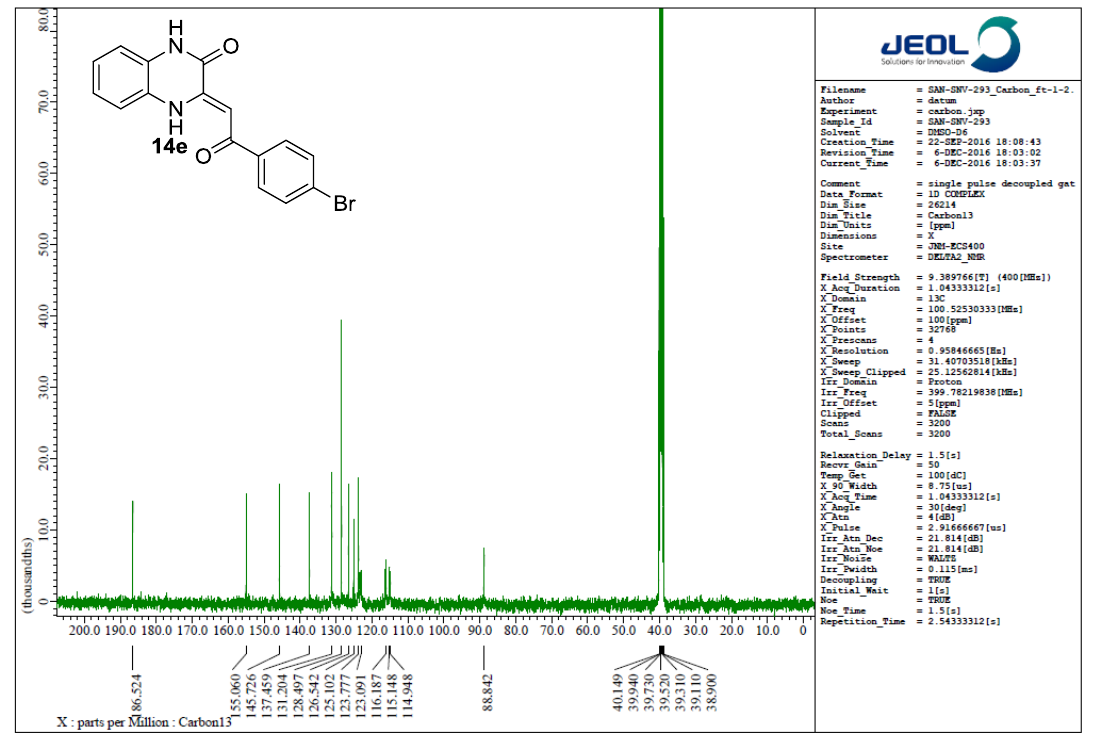
Figure 38 . 13 C NMR Spectra of Compound 14e